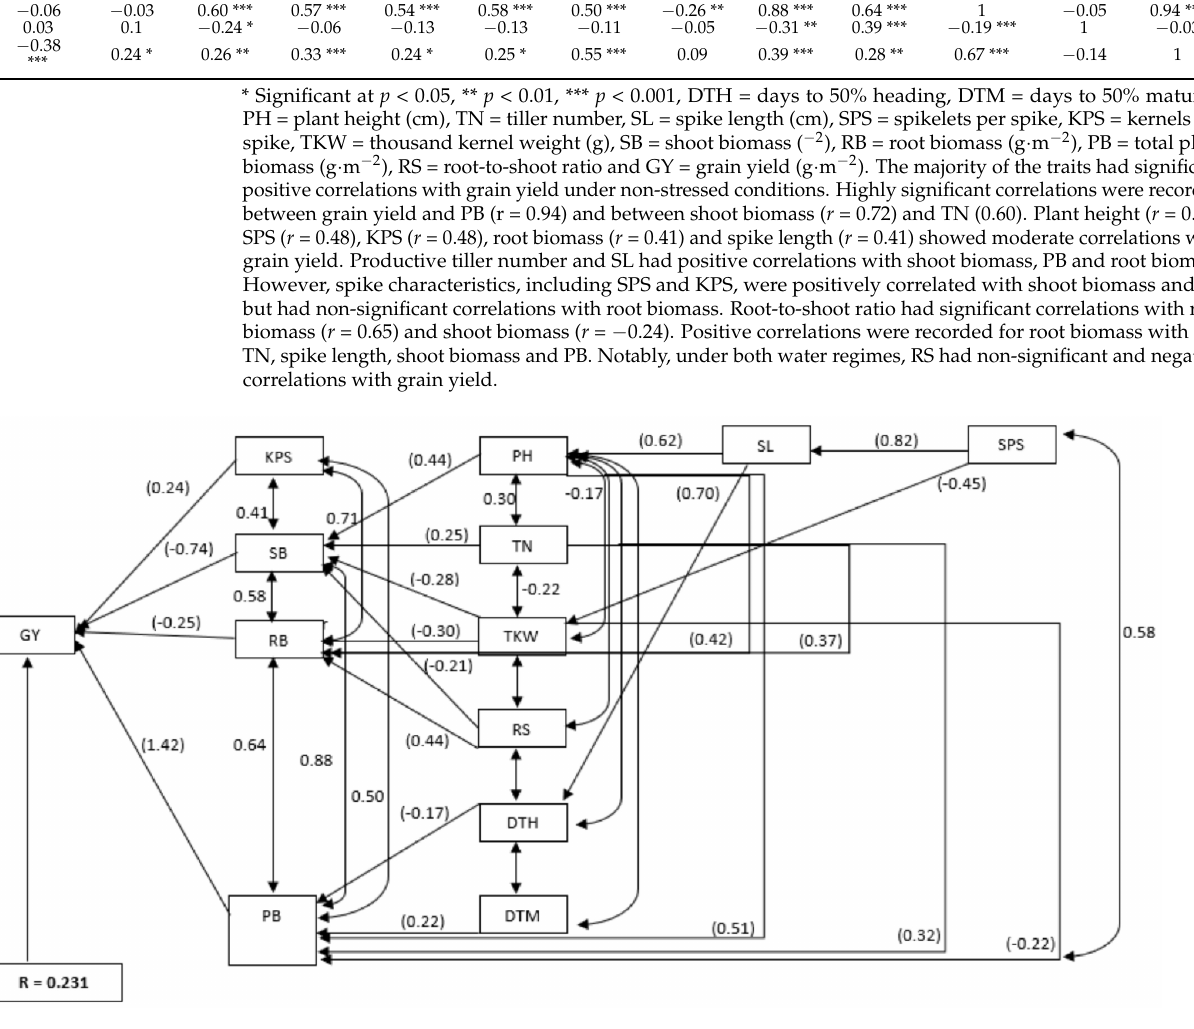
Figure 3. Path analysis model diagram displaying causal relationships of assessed traits on grain yield in 10 bread wheat parental lines and 90 derived F 2 families of wheat assessed under drought-stressed conditions. Values in parenthesis are direct path coefficients, while other values are correlation coefficients. R = residual effect; DTH = days to 50% heading, DTM = days to 50% maturity, PH = plant height (cm), TN = tiller number, SL = spike length (cm), SPS = spikelets per spike, KPS = kernels per spike, TKW = thousand kernel weight (g), SB = shoot biomass (g · m − 2 ), RB = root biomass (g · m − 2 ), PB = total plant biomass (g · m − 2 ), RS = root-to-shoot ratio and GY = grain yield (g · m − 2